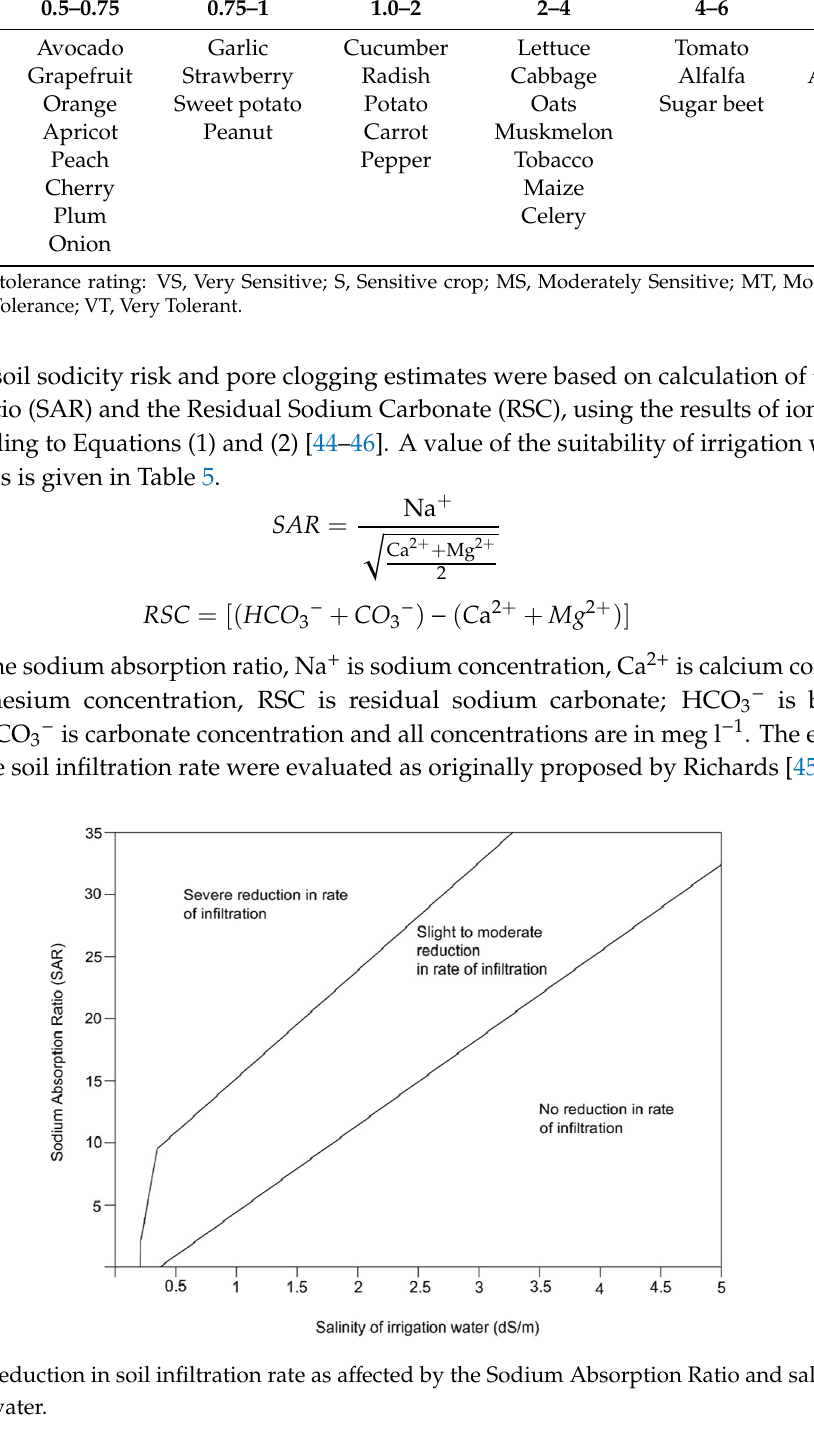
Table 4. Boron tolerance of selected crops (mg L − 1 ). Data adapted from [44]. VS S MS MT T VT < 0.5